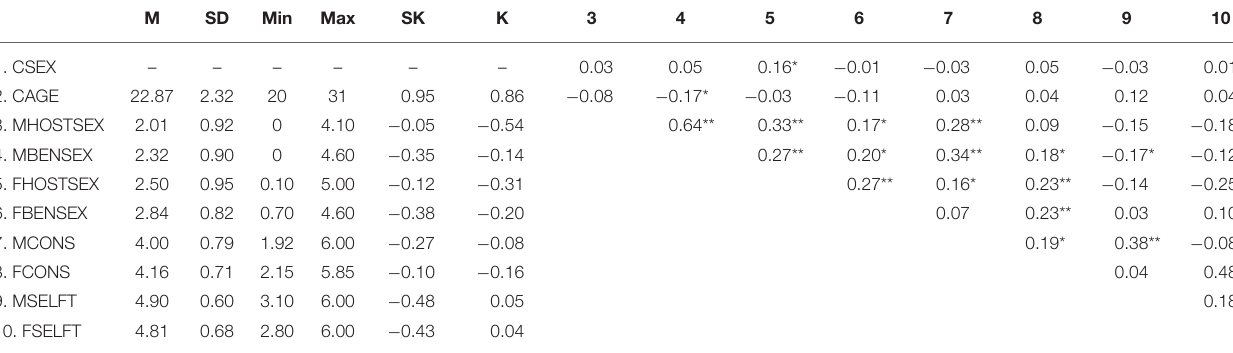
TABLE 1 | Descriptive statistics and correlations.